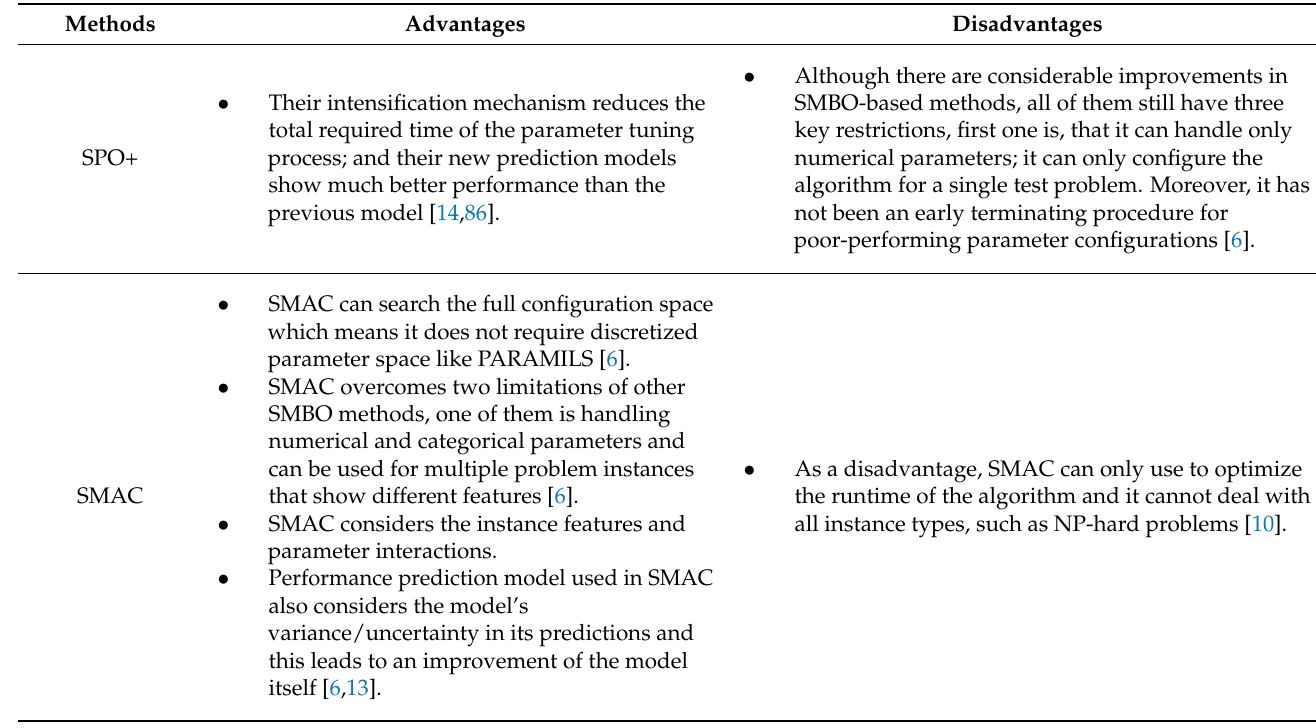
Table 3. A brief summary of main advantages and disadvantages of widely used model-based algorithm configuration